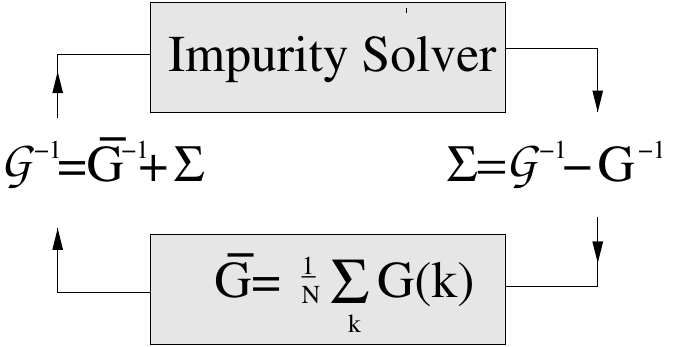
Figure 16. The DMFT/CPA self-consistency